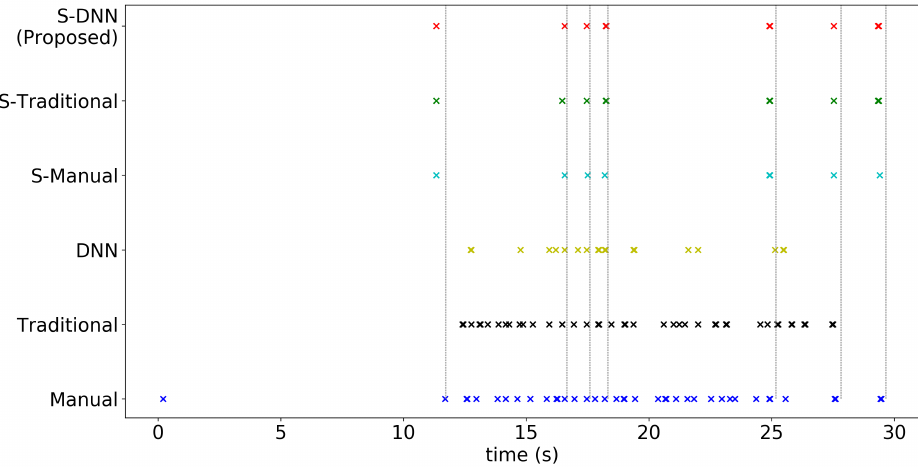
Figure A10. Prediction consistency of event counting compared with ground truths for capillary 4 (same as Figure 10).